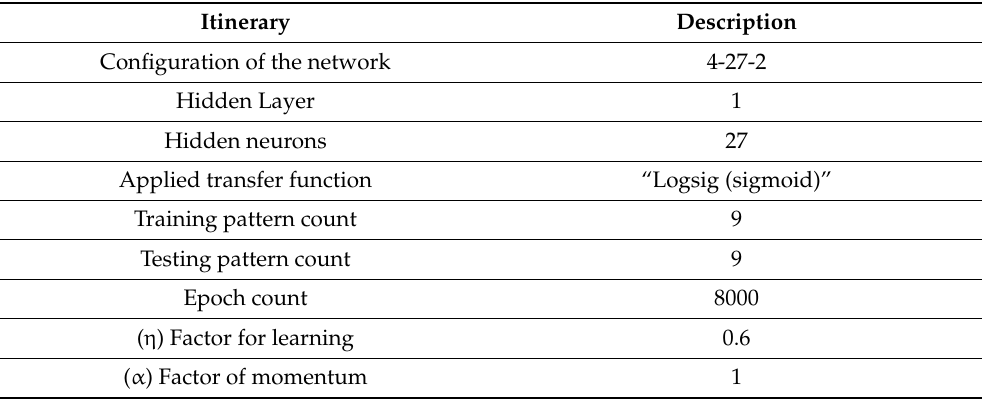
Table 9. Observations of the output